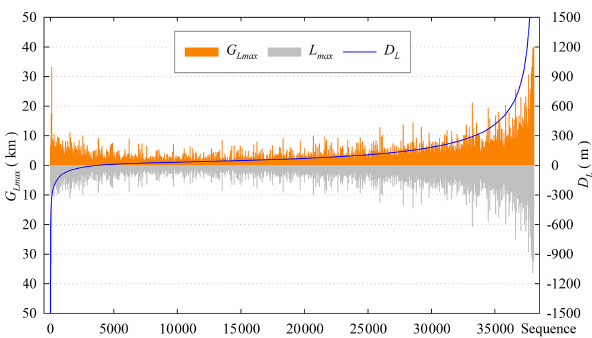
Figure 11. The statistical chart of the difference ( D L ) of the longest glacier length between this dataset ( G Lmax ) and the RGI v6.0 ( L max